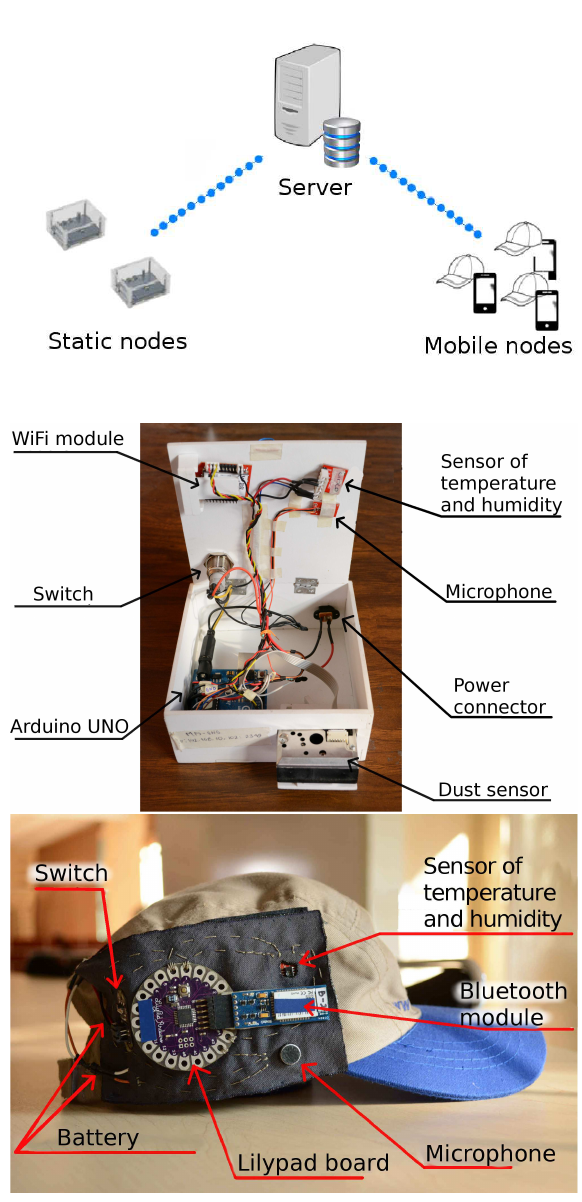
Figure 1. Architecture of the sensor network prototype (top), static node (middle), and mobile node (bottom)